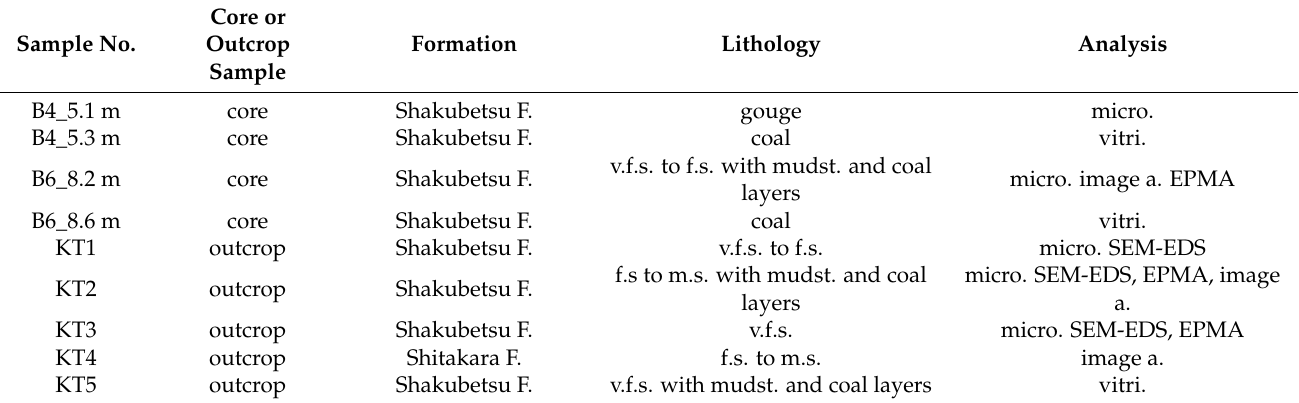
Table 2. Summaries of analyzed samples.